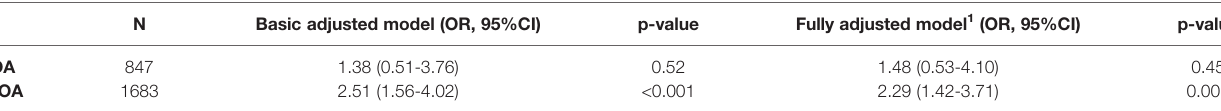
TABLE 2 | Association between baseline sarcopenia and incident knee OA